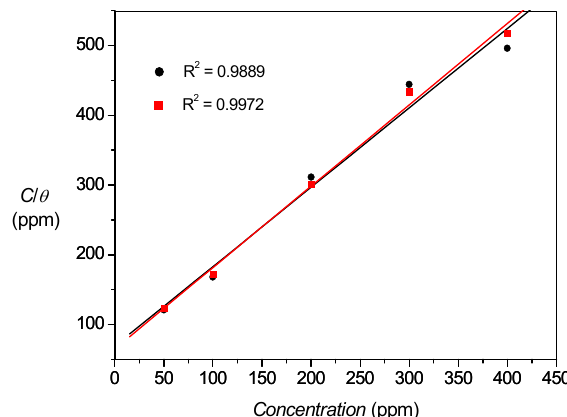
Figure 5. Langmuir adsorption isotherms of SB adsorption on mild steel surface from ( ▪ ) polarization and ( ● ) impedance experiments.